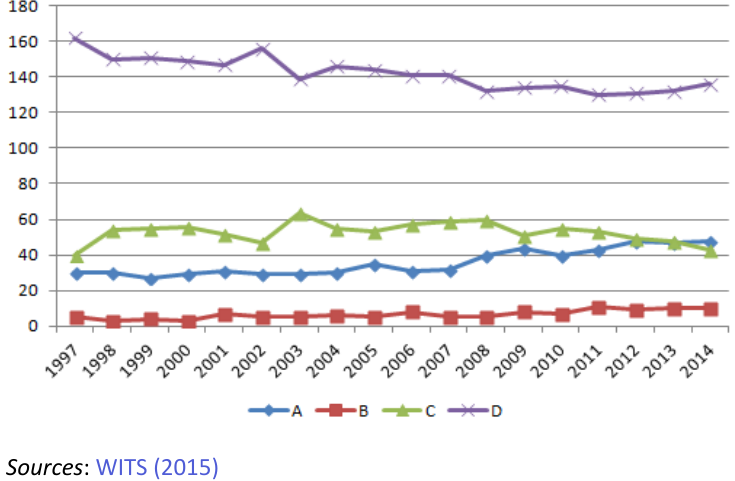
Figure 3: Trends in Number of Products Groups A, B, C and D of Malaysia, 1997-2014 Philippines has positive trend for products A until 2013 but then decrease in 2014. Flat trend for products B and D, and positive trend for products C. It shows that Philippines quite stagnant on its comparative advantage and exports